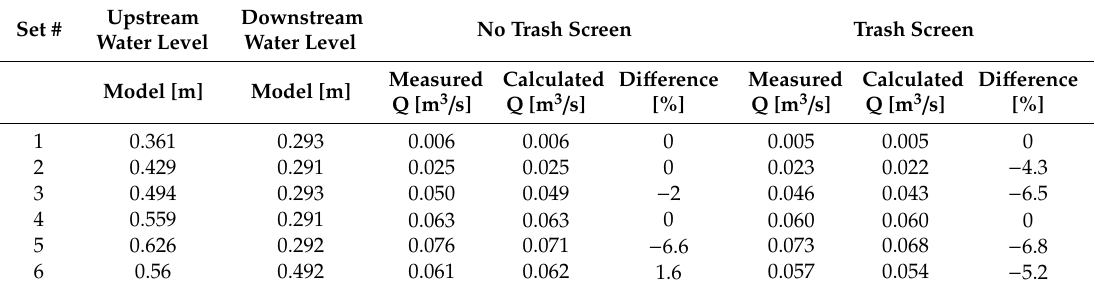
Table 5. Results of flume scale model compared with the calculated